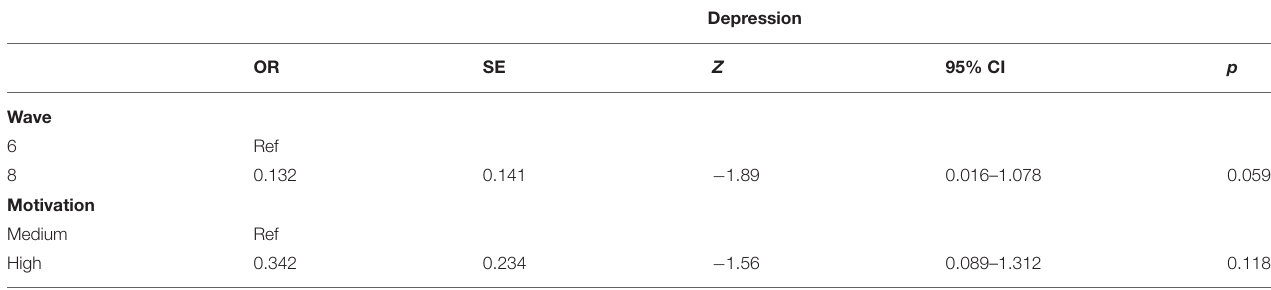
TABLE 3 | Results of multivariate analysis of factors related to depression.